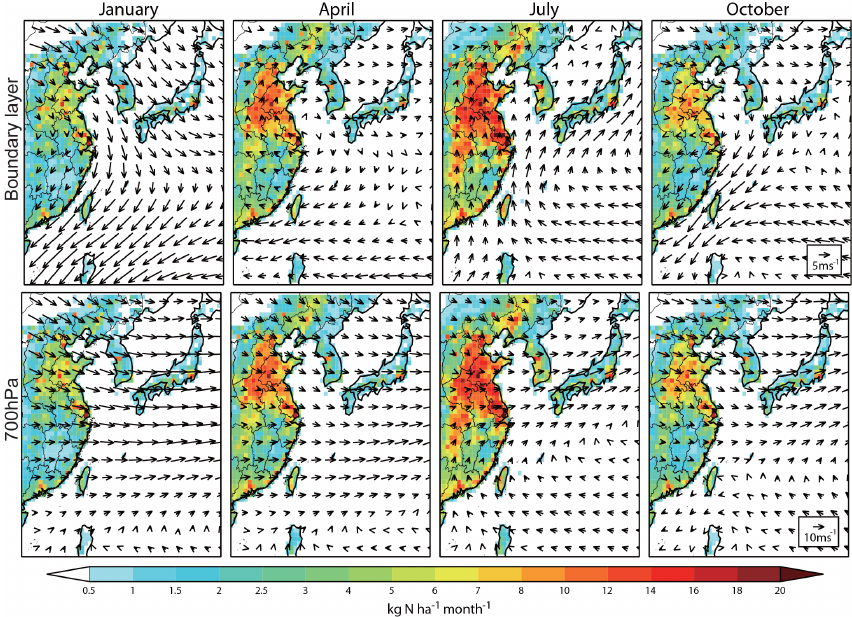
Figure 10. Monthly mean wind fields from the GEOS-5 assimilated meteorological data over-plotted on the monthly emissions of fixed nitrogen (NH 3 + NO x ) . The top panels are wind fields in the boundary layer (1000–950hPa) and the bottom panels show the wind fields in the free troposphere